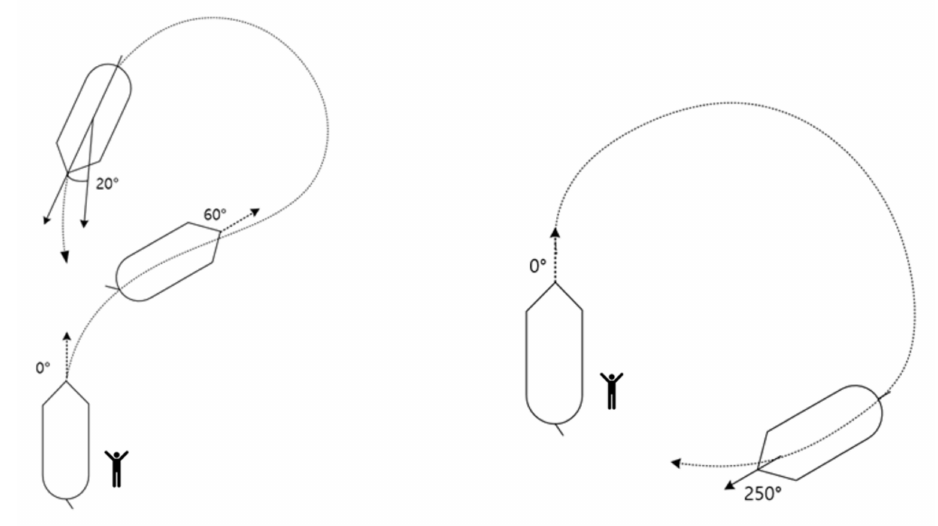
Figure 1. Williamson turn ( left ) and Anderson turn ( right